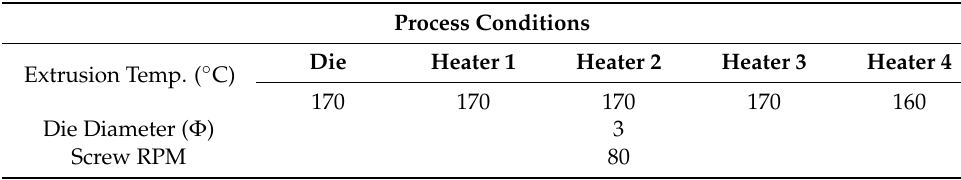
Table 2. Process conditions of extrusion process.